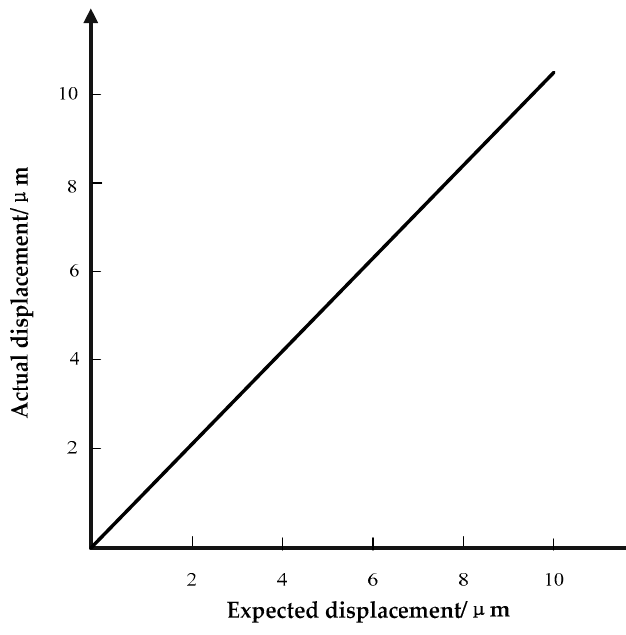
Figure 16. Desired relation of expected displacement and actual displacement.